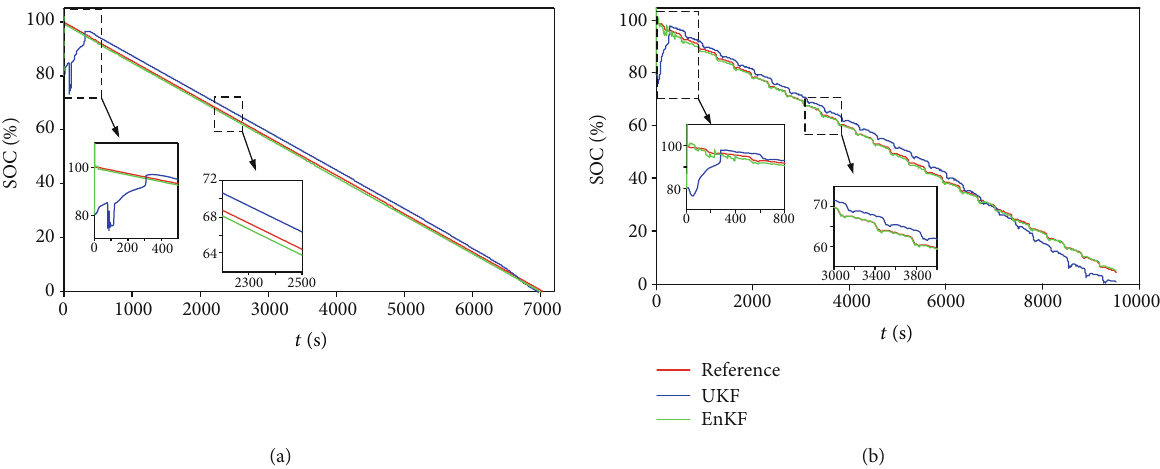
Figure 5: (a) Comparison of SOC estimation in experiment 1. (b) Comparison of SOC estimation in experiment 2.